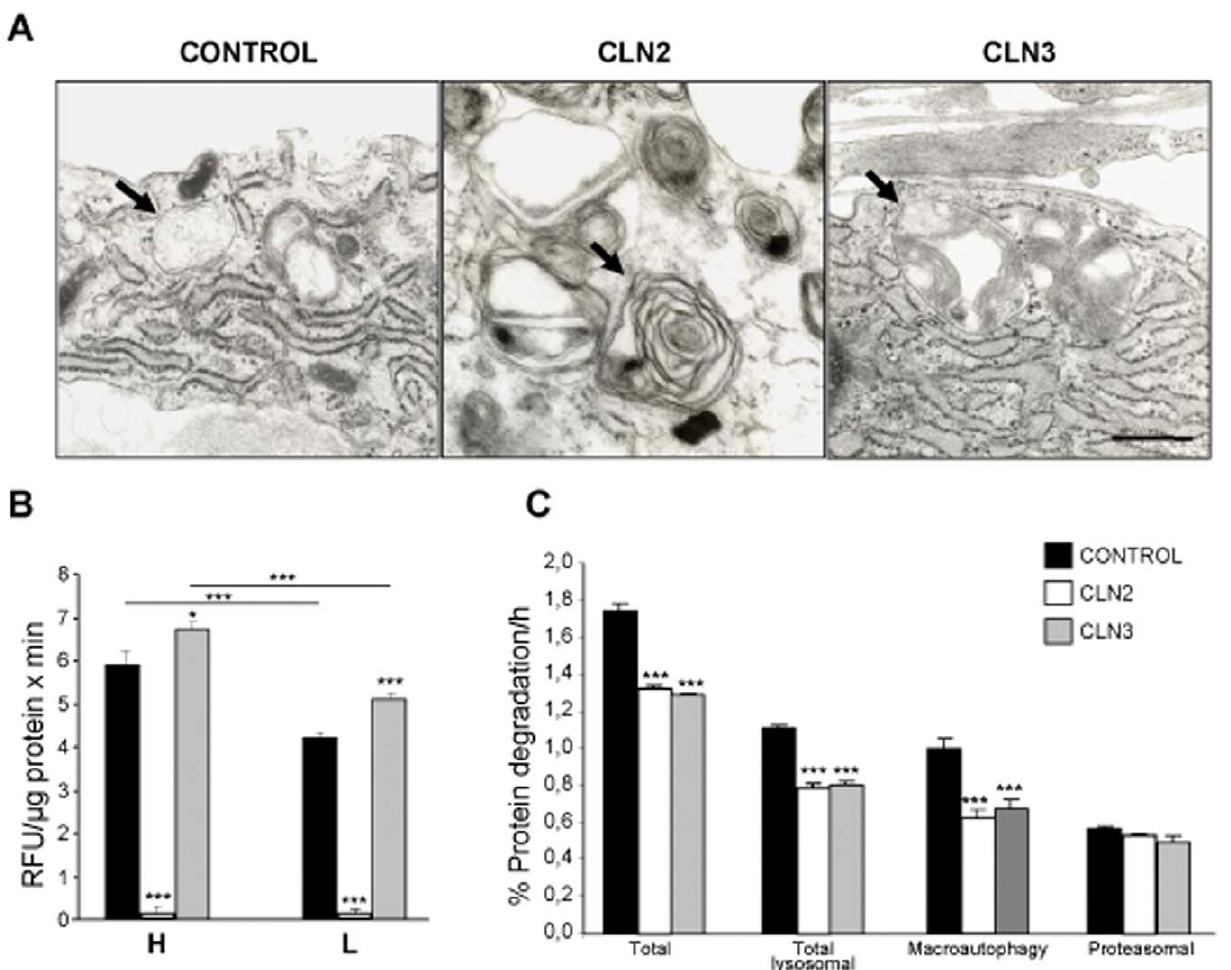
Figure 1. Lysosomal alterations in NCL fibroblasts. (A) Representative electron micrographs of control, CLN2 and CLN3 fibroblasts incubated in high proteolysis medium to activate autophagy. Arrows indicate lysosomal vacuoles. Bar: 0.5 m m. (B) TPP1 activity measurements. Control (black bars), CLN2 (white bars) and CLN3 (gray bars) fibroblasts were incubated under high (H) and low (L) proteolysis conditions as indicated. TPP1 activity and total protein were measured as described in Materials and Methods. Results are expressed as RFU values per minute and m g protein, and are the mean and S.D. from three separate experiments with triplicated samples. (C) Pulse-chase experiments. Labelling of human fibroblasts with [ 3 H] valine in high proteolysis medium, measurements of degradation of long-lived proteins and the contribution of lysosomal (total and macroautophagy) and proteasomal pathways were carried out as described in Materials and Methods. Results are presented as the percentage of the labelled protein that is degraded per hour, and are the mean and S.D. from eight to fifteen separate experiments with duplicated samples. In B and C, stars immediately on top of bars indicate statistically significant differences from control values (*p , 0.05 and ***p , 0.005). proteases (Figure 2A). LC3-I is a microtubule-associated protein that is lipidated to LC3-II upon activation of macroautophagy.